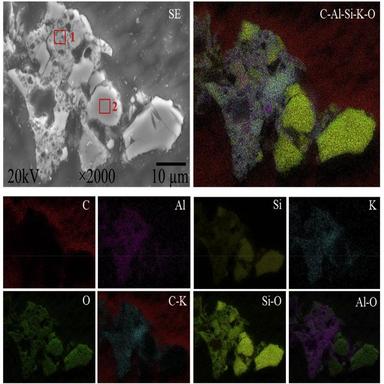
SEM image of SCBA grains and corresponding element mappings based on EDS.